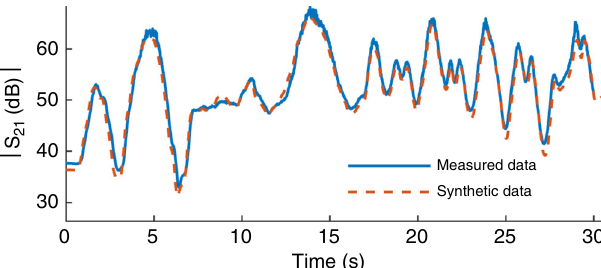
Fig. 1 Measured vs synthetic magnetic induction (MI) data. The measured and simulated voltage gain of two MI coils during arbitrary movement, such that both relative alignment and location of